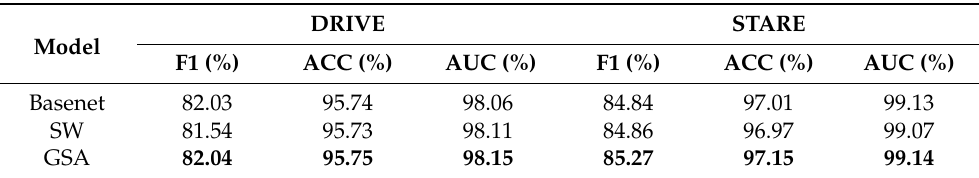
Table 5. Quantitative performances of the models based on different self-attention modules in retinal segmentation task.